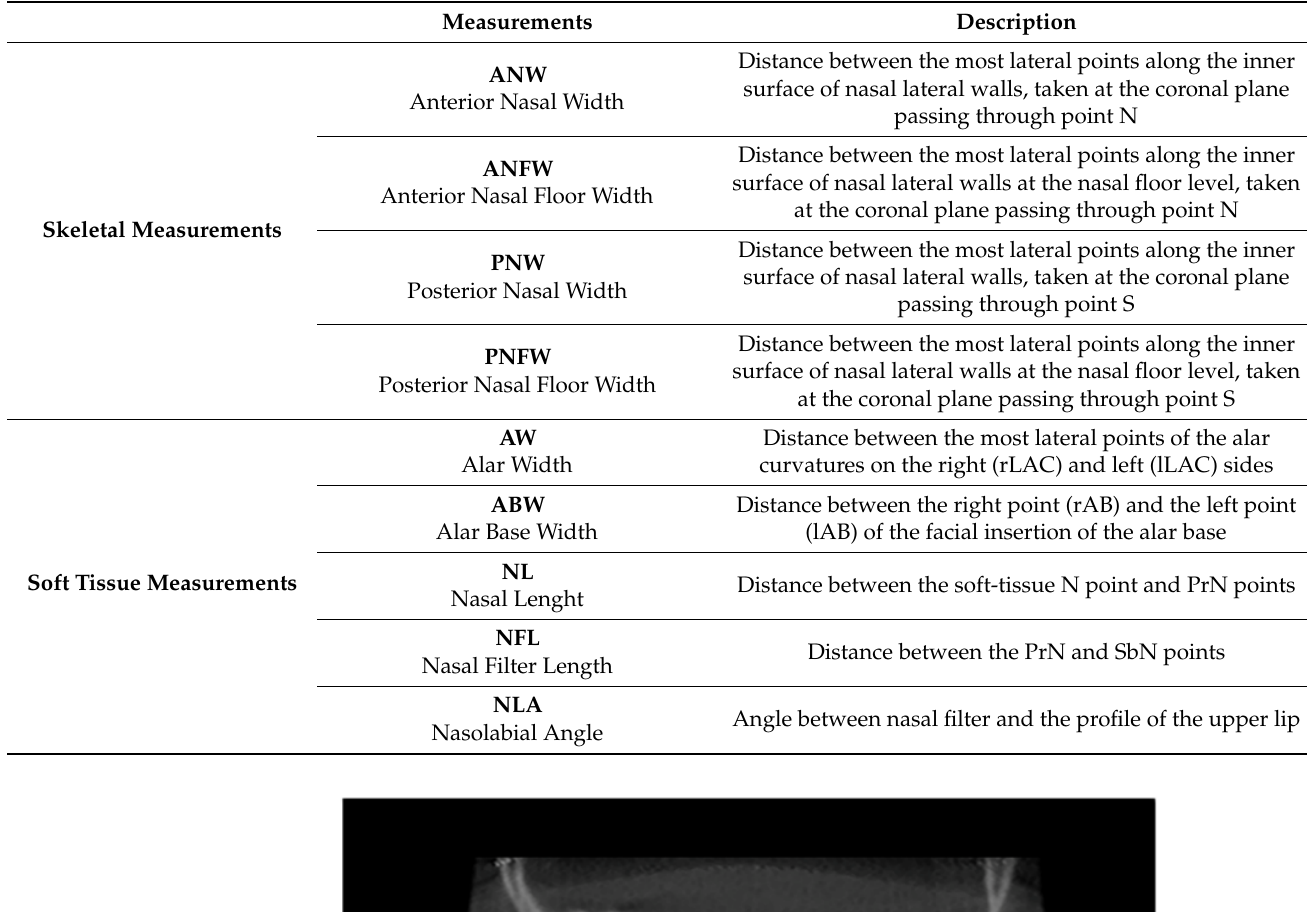
Table 1. Description of the linear measurements used in the present study.